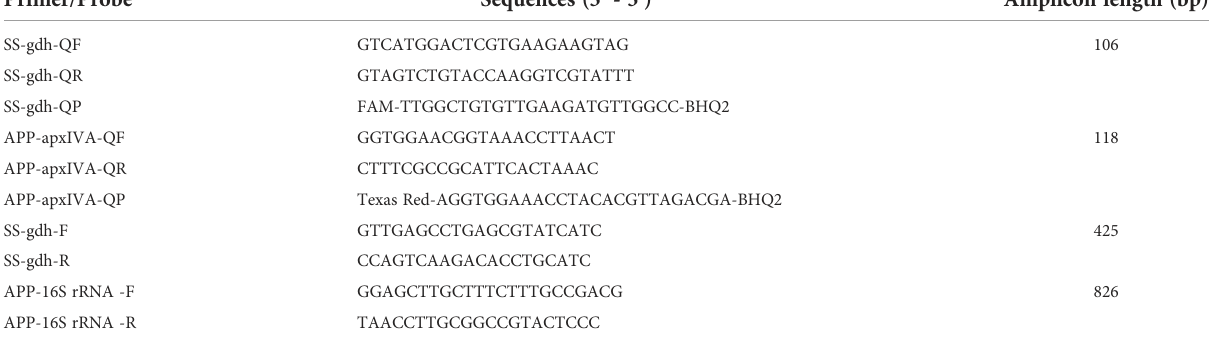
TABLE 1 Primers and probes used in this